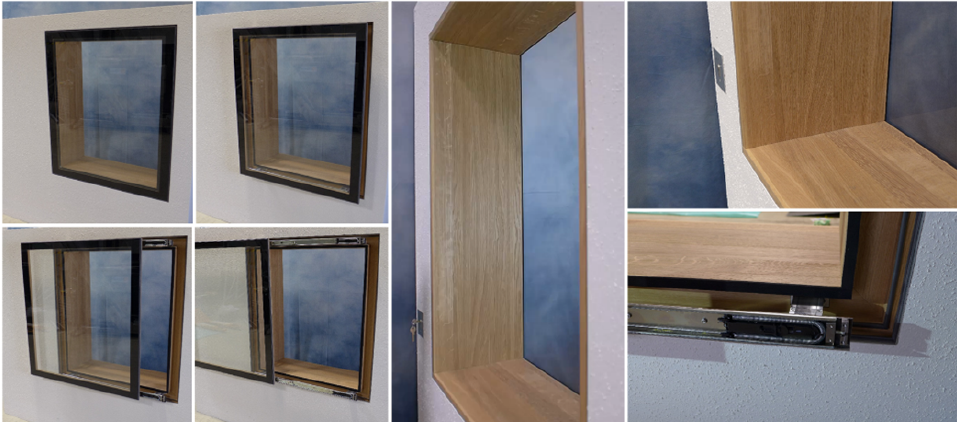
Figure 10. Window prototype S. From left to right: Thumb cinema of the opening process, window and fitting detailing.